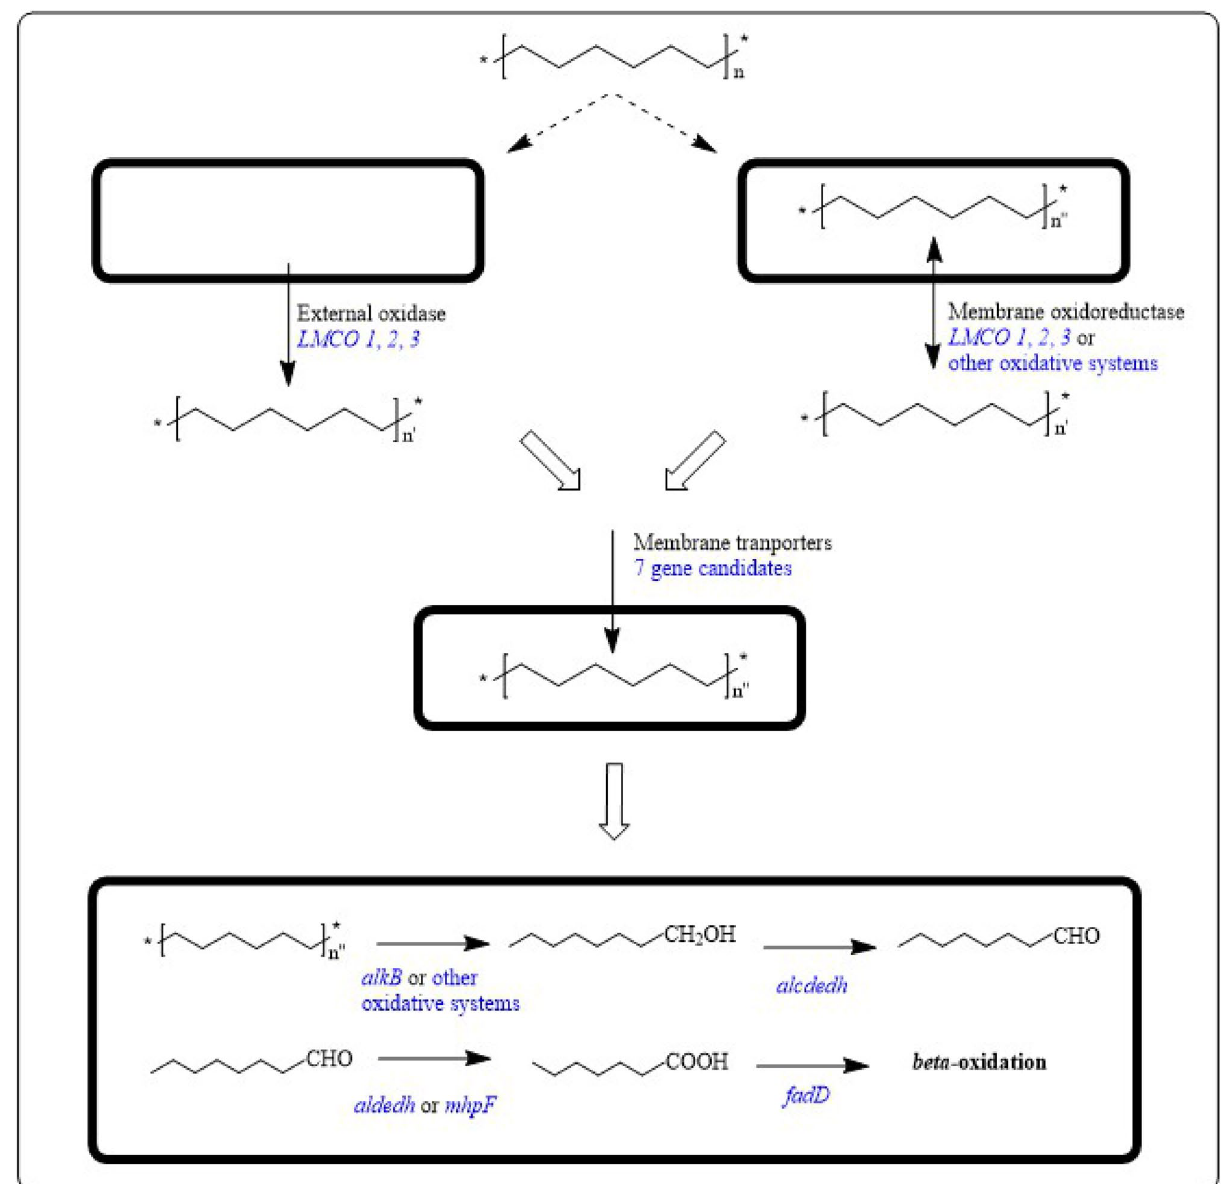
Figure 7. Proposed metabolic pathways of R . opacus R7 for polyethylene degradation. Blu genes represent candidate genes involved in PE metabolism: LMCO 1 , LMCO 2 , and LMCO 3 , laccase-like multicopper oxidase; membrane oxidoreductase or other oxidative systems include alkB system; alkB , alkane monooxygenase; alkB or other oxidative systems include cyp450 , cytochrome P450 hydroxylase. Membrane transporters include integral membrane proteins. alcdedh , alcohol dehydrogenase; aldedh , aldehyde dehydrogenase; mhpF , acetaldehyde dehydrogenase; fadD , long-chain-fatty-acid-CoA ligase. Names of enzyme categories reported in black color represent candidates for each metabolic step. Dashed arrows indicate hypothetical metabolic steps. Full white arrows indicate required metabolic